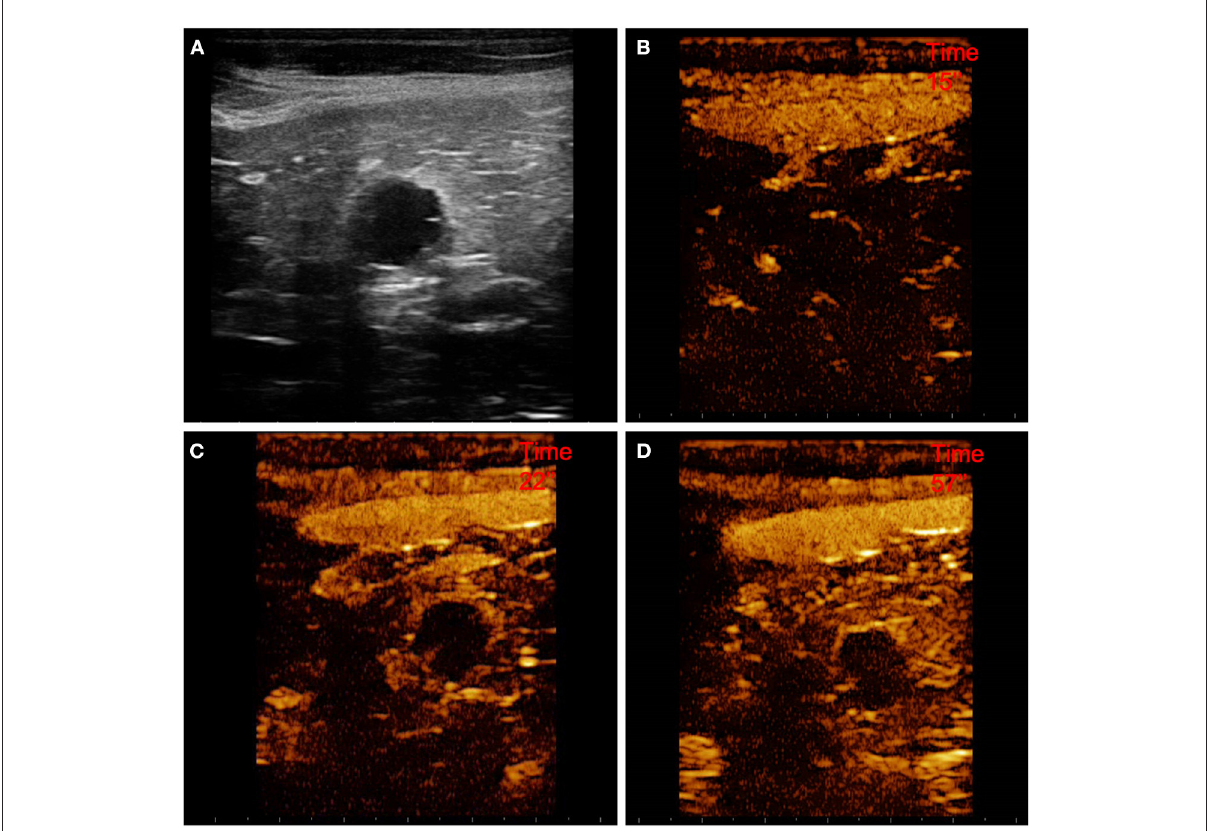
FIGURE4 Example of a cystadenoma (OBL) showing: pseudocystic appearamce, mixed echogenicity, presence of acoustic enhancement, and presence of peripancreatic reactivity at US; hyperenhancement, peripheral and homogeneous distribution of contrast medium, presence of intralesional microcirculation, and presence of hypoperfused areas during wash-in at CEUS; no wash-out. (A) Image obtained from US examination; (B) image obtained at TTE; (C) image obtained at TTP; (D) image obtained during wash-out.